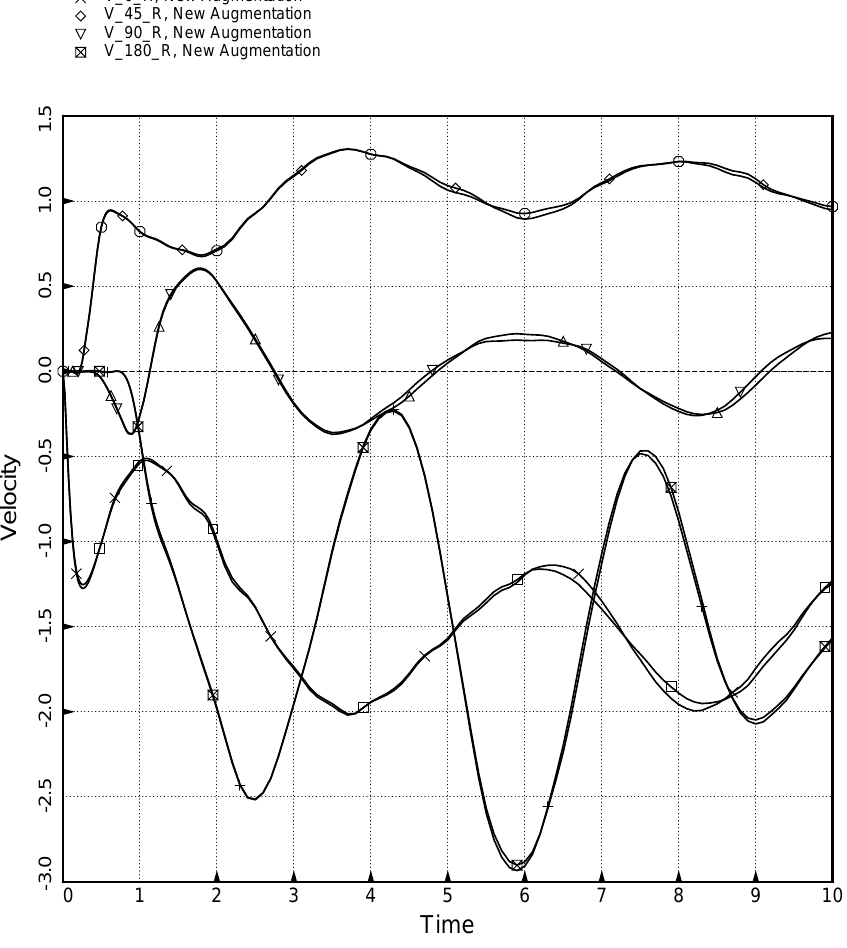
Fig. 6. Sphere, DAA 2c, Singular mass in new